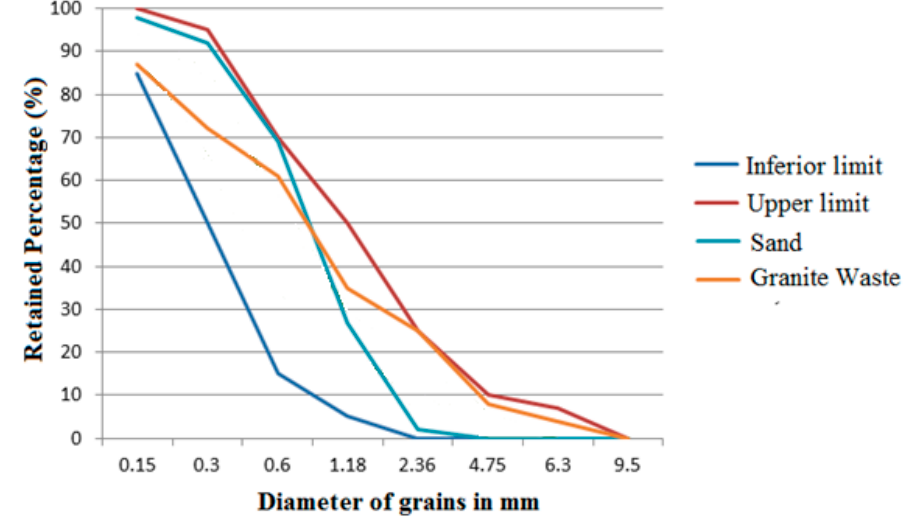
Figure 4. Result of the physical characterization of the fine aggregate (sand) and the granite